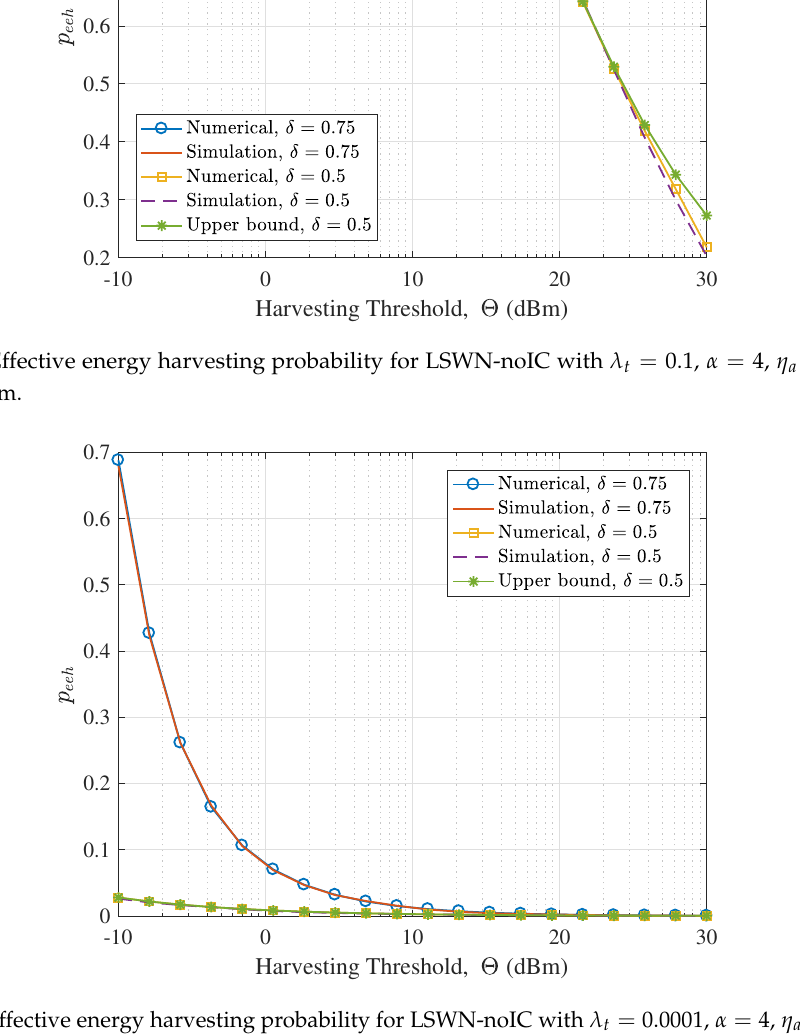
Figure 5. Effective energy harvesting probability for LSWN-noIC with λ t = 0.0001, α = 4, η a = 1 and P et = 30